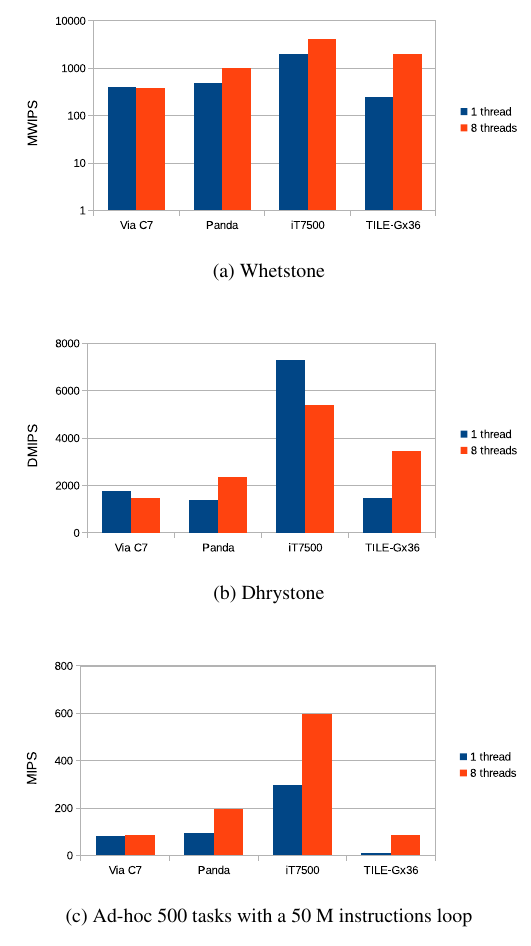
Figure 2: Benchmarking results in